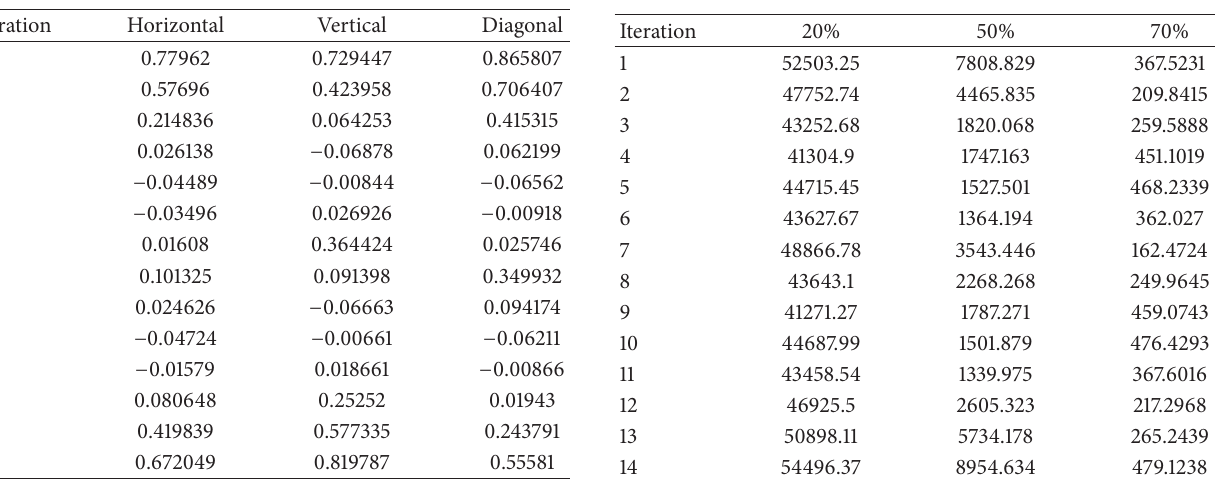
Table 4: The evaluation results of Figure 3 by normalized autocor- relation on different directions.